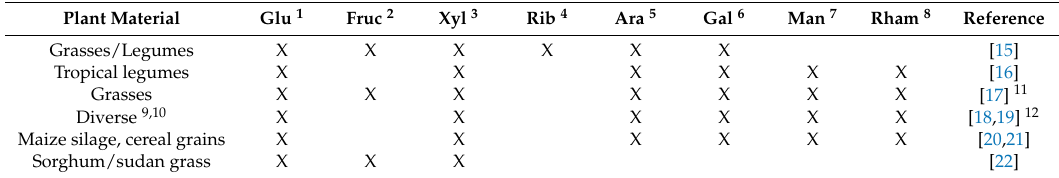
Table 2. Cell wall monosaccharides in plants for